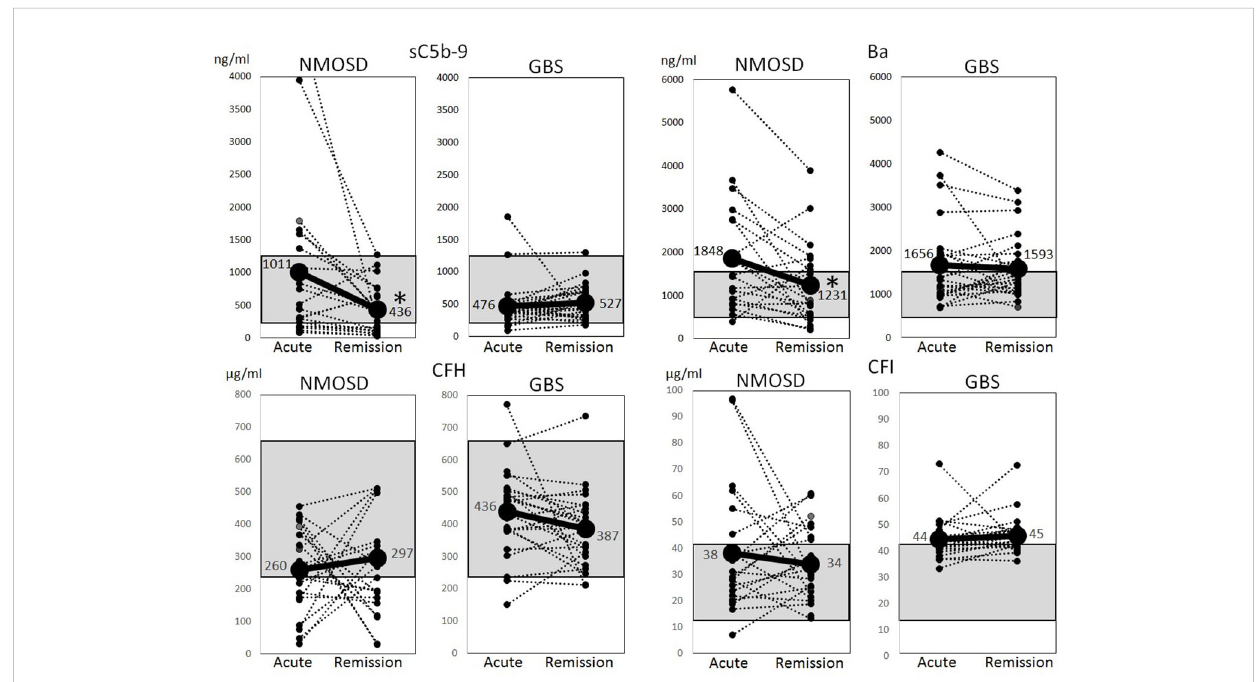
FIGURE 2 Changes of complement markers during the acute and remission phases of neuromyelitis optica spectrum disorders and Guillain-Barre ́ syndrome. Changes of serum levels of sC5b-9, Ba, complement factor H and complement factor I during the acute and remission phases of neuromyelitis optica spectrum disorders and Guillain-Barre ́ syndrome were analyzed. The dotted lines indicate changes in individual cases, and solid lines indicate changes in average levels. The gray shadow indicates reference ranges in healthy Japanese adults (sC5b-9: 181 – 1266 ng/ml, Ba: 438 – 1546 ng/ml, complement factor H: 238 – 663 µg/ml, complement factor I: 11 – 42 µg/ml) (15). * p < 0.01, paired